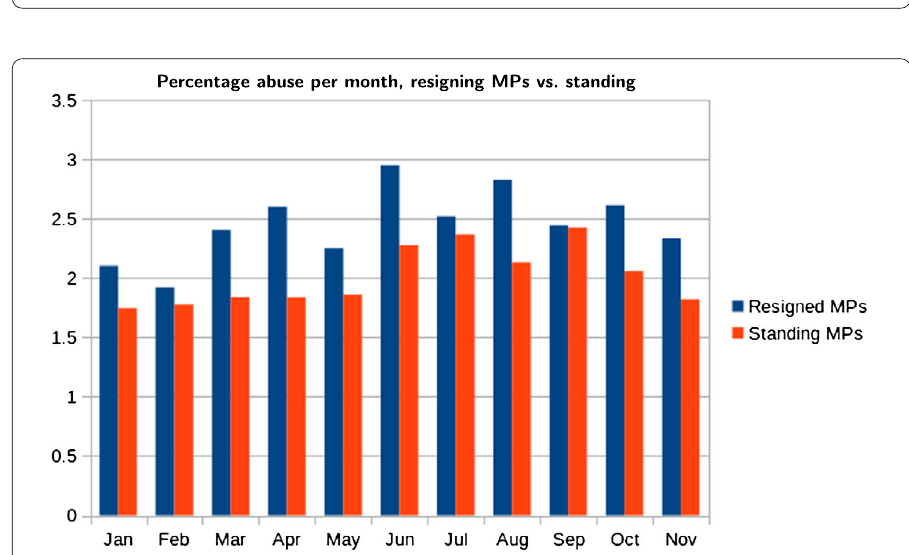
Figure 12 Percentage abuse per month, resigning MPs vs. standing. Macro-averaged percentage abuse per month per individual for those MPs who chose to stand again vs those who chose not